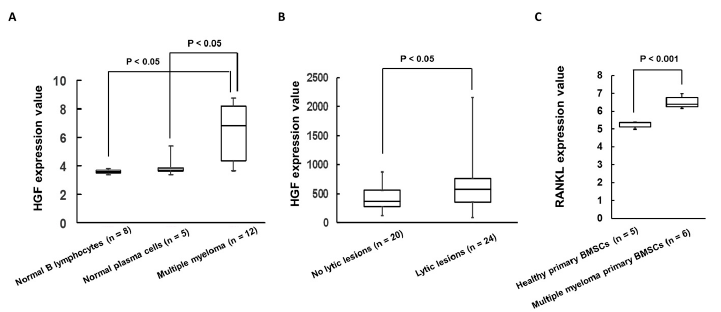
Figure 1. ( A , B ) The expression of HGF was analyzed using the ( A ) GSE6691 and ( B ) GSE755